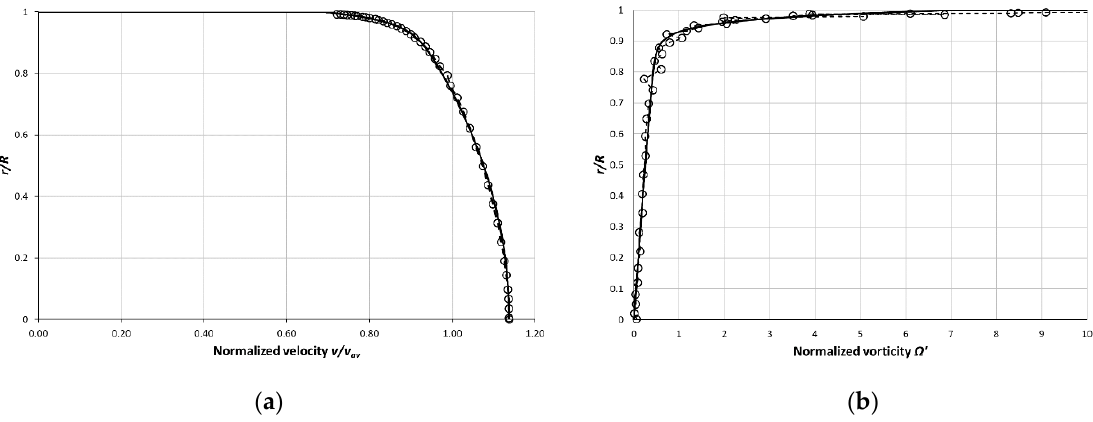
Figure 14. The analytical formula comparison with the experimental data (PSP) for Re = 13,598,000, using variables Ω (w) , D (1) , K, and N . Dashed line with circles represents the experimental data, the solid line is the analytical profile. ( a ) Normalized mean velocity profile, ( b ) Normalized vorticity distribution.